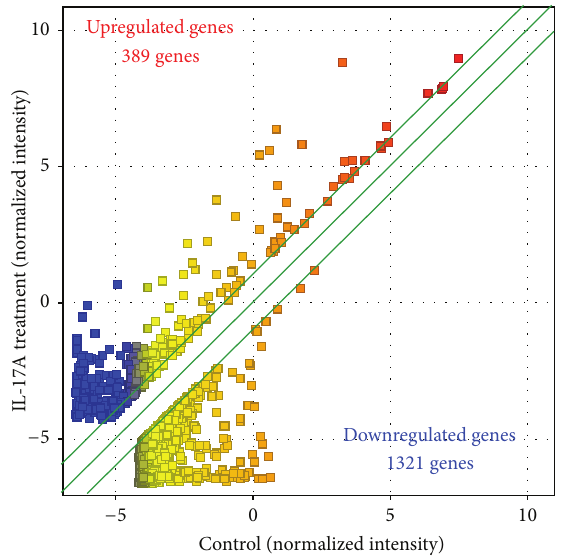
Figure 2: Scatter plots of microarray analysis. Of the 50,739 genes on the DNA microarray, the 27,583 genes that were expressed in synovial fibroblasts were compared between synovial fibroblasts treated with IL-17A and nontreated control. Of these 27,583 genes, 1,710 genes (389 upregulated genes and 1321 downregulated genes) showed a greater than twofold difference between IL-17A-treated and control